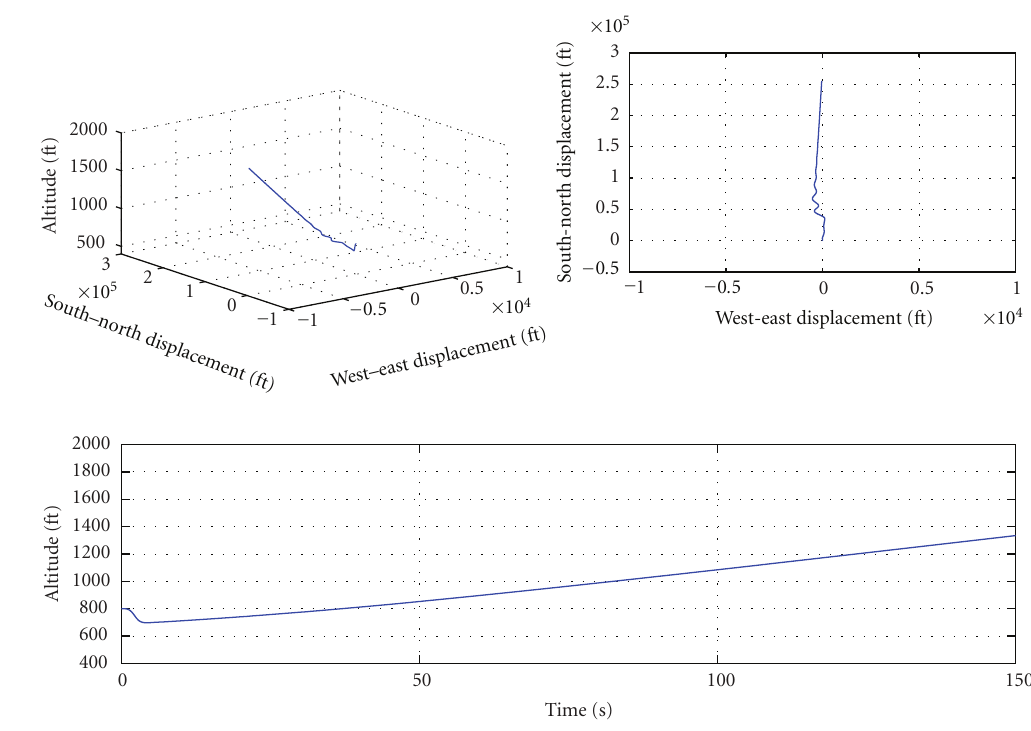
Figure 19: Flight trajectory, ground track, and altitude of the aircraft.